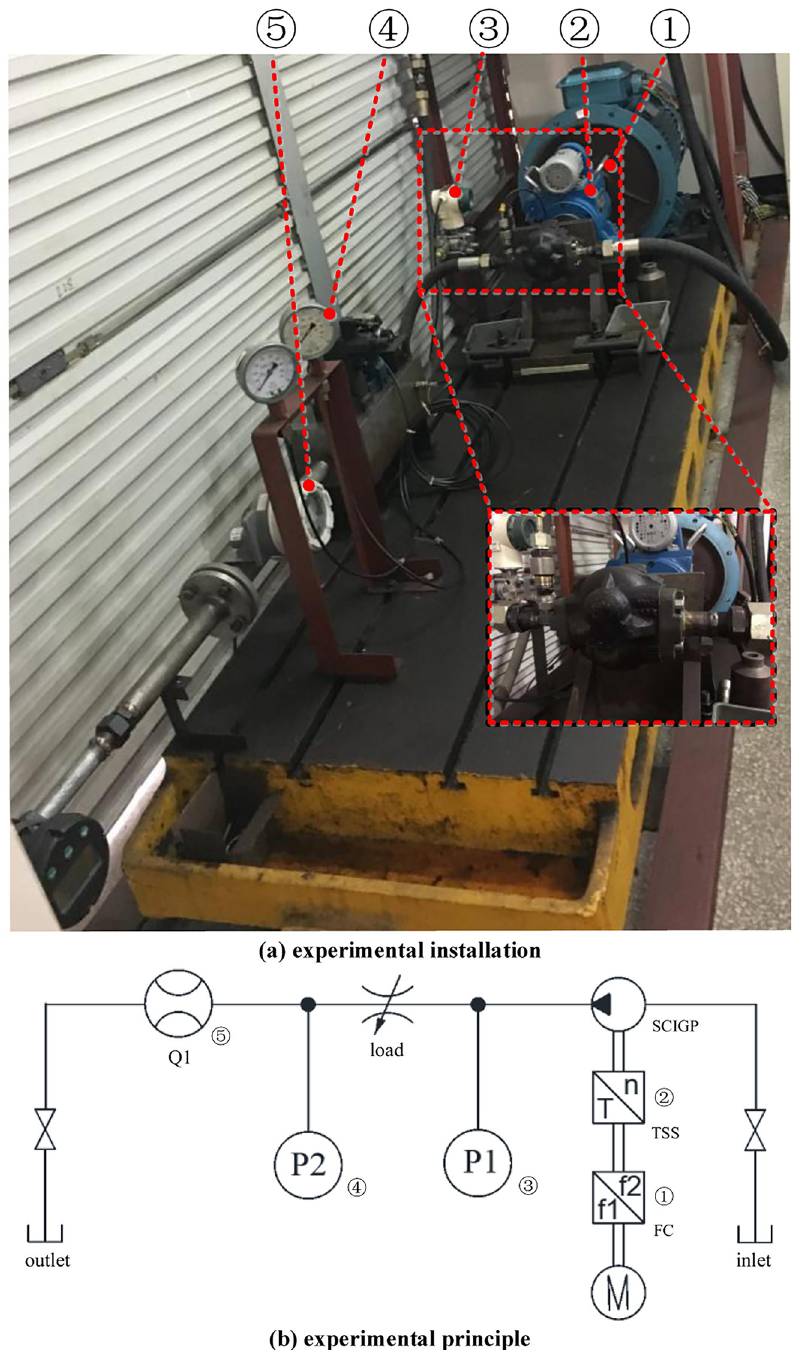
Fig 18. Test system. (a) experimental installation. (b) experimental